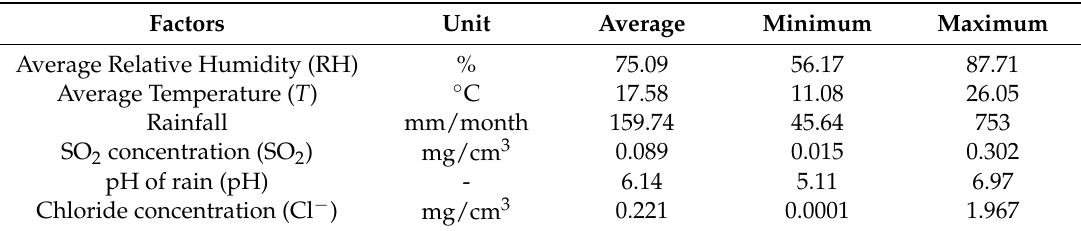
Table 2. Environmental factors and their